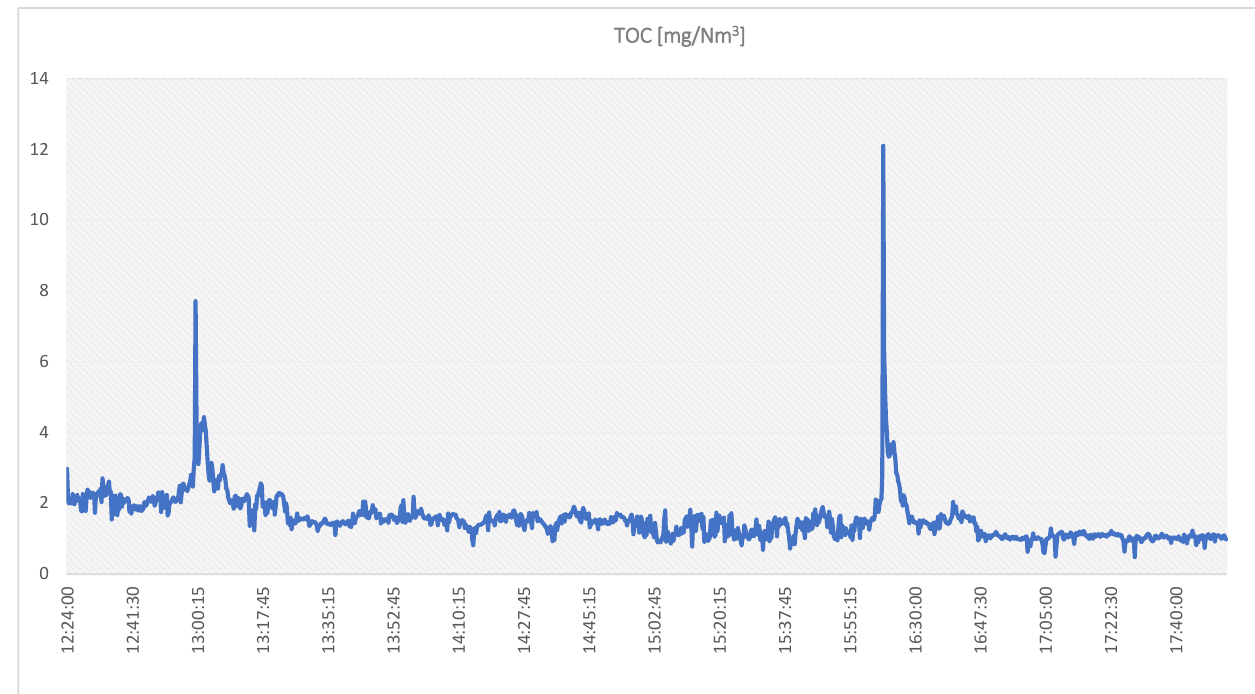
Figure 5. SO 2 emission trend during combustion test.